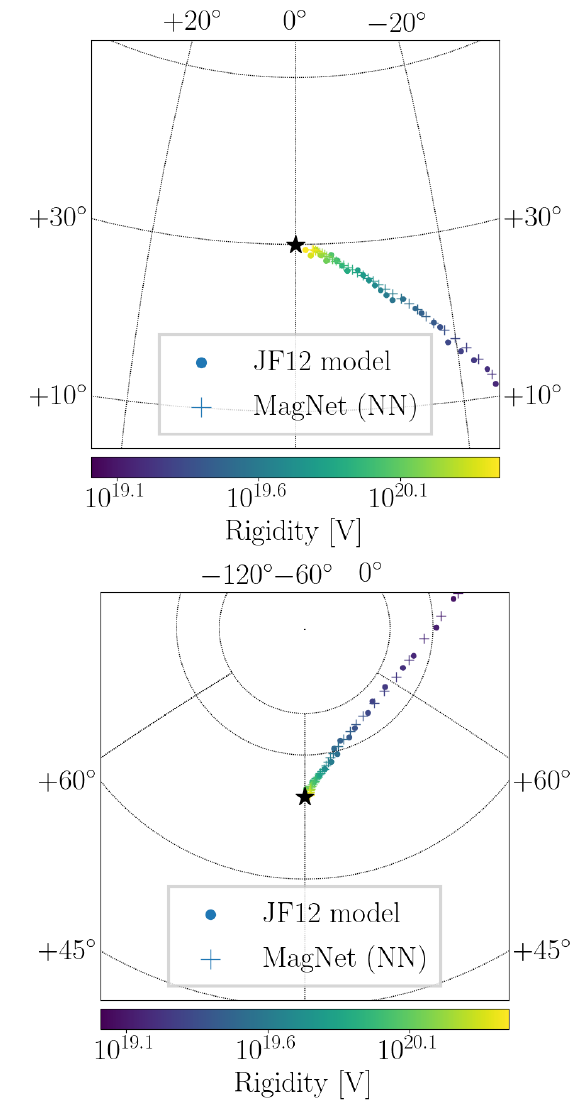
Figure 3. Arrival directions p i for cosmic rays from two arbi- trary directions ˆ s i outside the galaxy denoted by the black star. The circles represent the simulations through the analytical JF12 model with the cosmic ray propagation software CRPropa3 [7], and the cross symbols the predictions of the neural network for di ff erent rigidities R i = ˆ Z i / E i